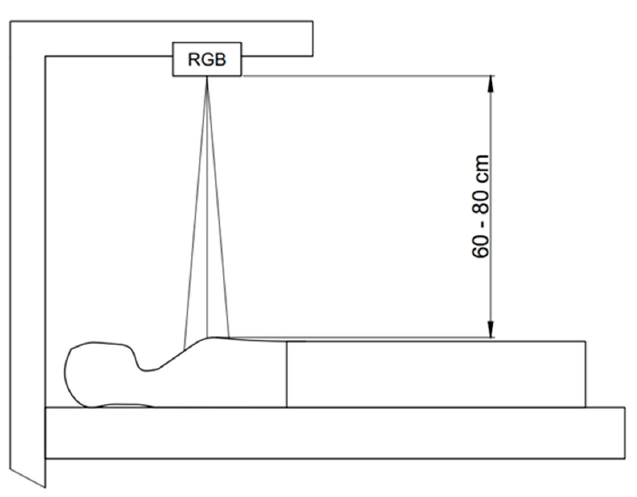
Figure 1. Schematic representation of the camera set-up.